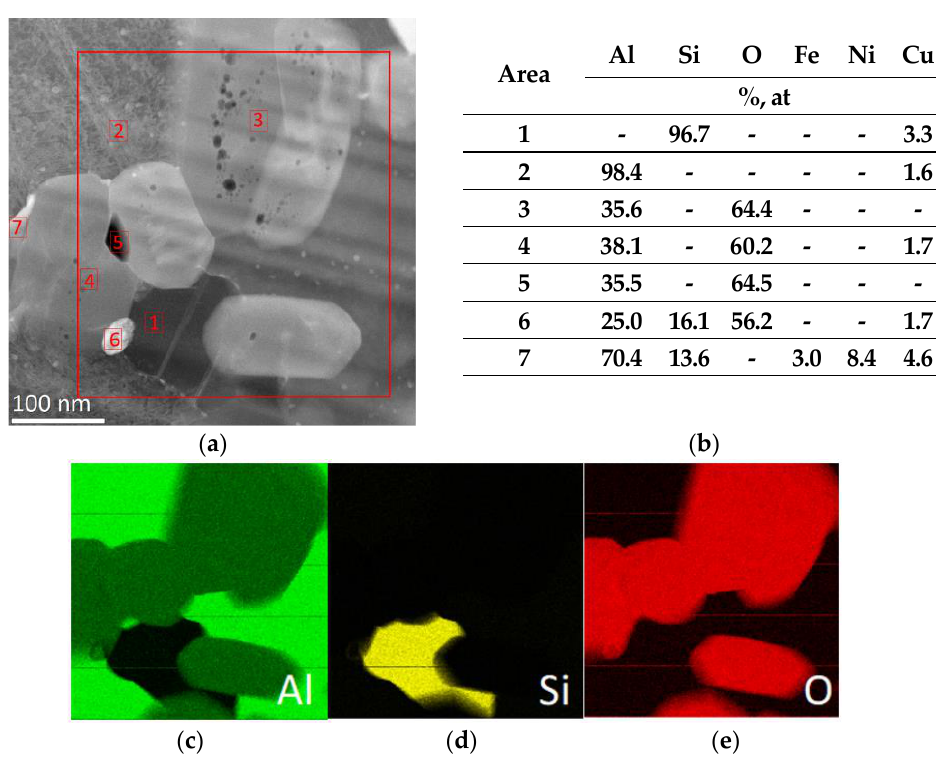
Figure 8. The results of the chemical composition analysis obtained using the characteristic EDS X-ray dispersion spectroscopy ( a ) obtained in the areas indicated in the microscopic image of the composite material produced by sintering the ceramic phase at 1600 °C, infiltrated at a pressure of 3 MP. EDS composition for points 1 – 7 ( b ), maps of Al ( c ), Si ( d ), and O ( e ).